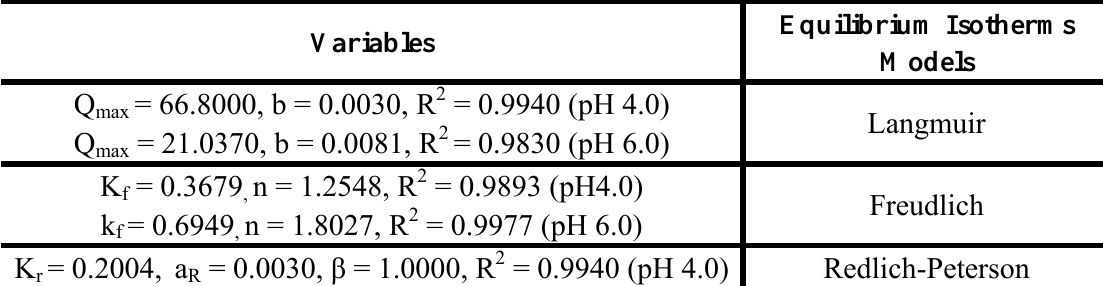
Table 2. Adsorption constants and fitting regression parameters for the isotherm models studied for Cr(VI) onto chitosan/zeolite film, at pH 4.0 and